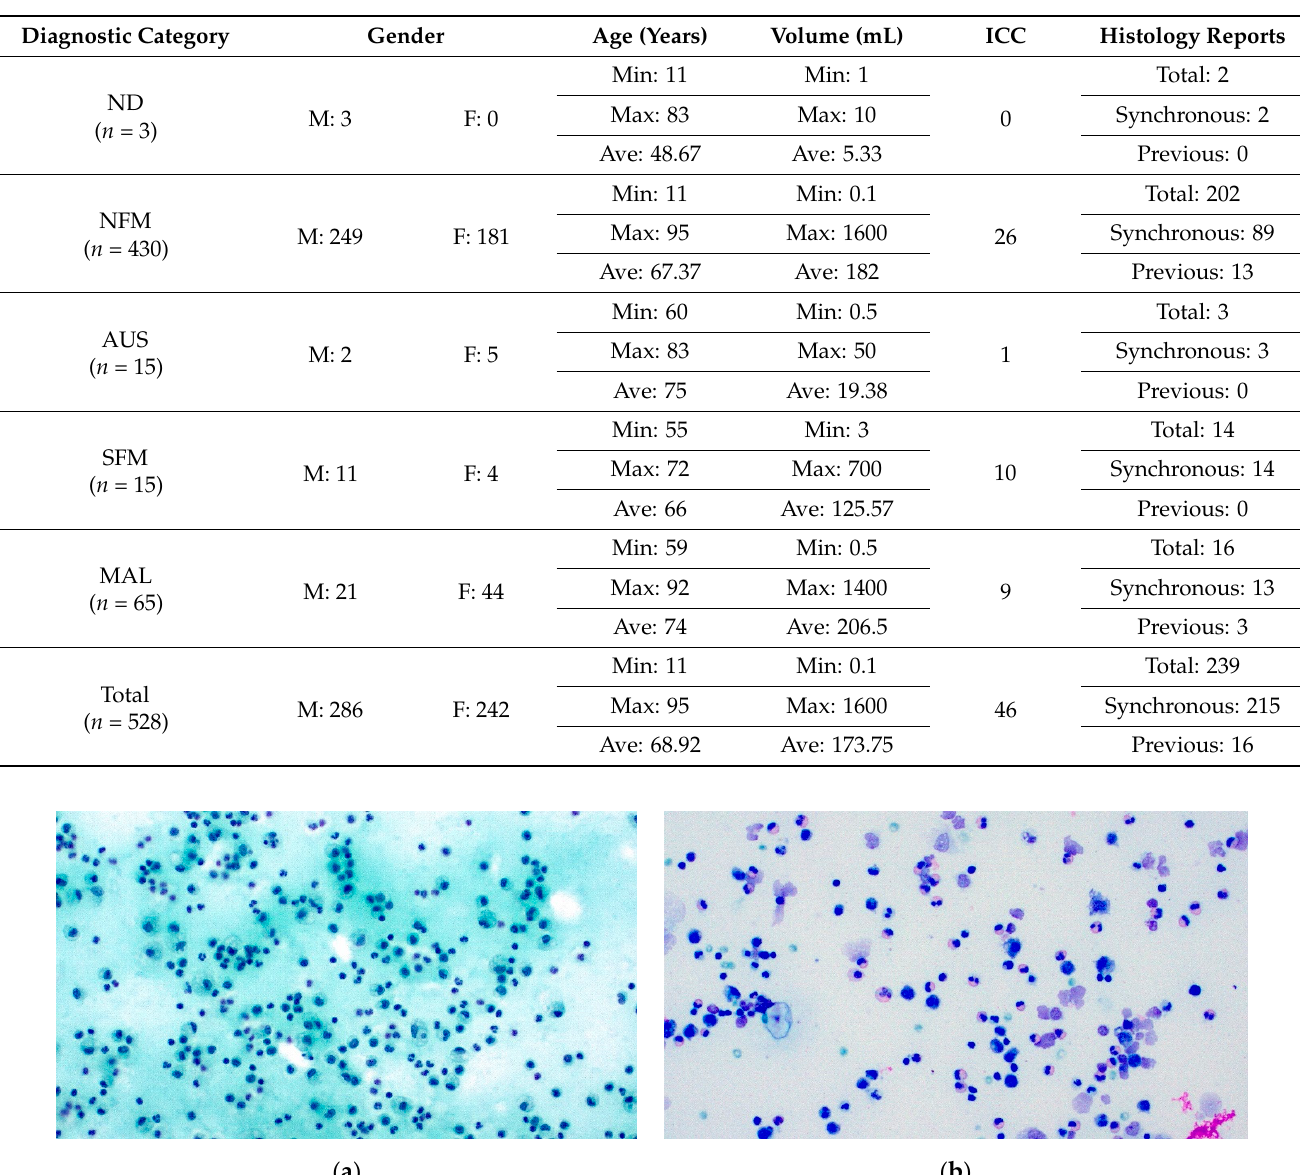
Pleural effusion cases consisted of 286 male and 242 female patients (male to female ratio = 1.18), with age ranging from 11 to 95 years old and median age equal to 68.92 years. Mean specimen volume amounted to 173.75 mL (ranging from 0.1 to 1600 mL). Of 528 cases in total, 3 were classified as ND (0.57%), 430 as NFM (81.44%), 15 as AUS (2.84%), 15 as SFM (2.84%), and 65 (12.31%) were positive for malignancy. ICC was conducted in 46 of the cases. Data are presented in Table 2, and examples of benign and malignant pleural effusions are shown in Figures 1 and 2. Table 2. Number of pleural effusion cases and gender, age, volume, ICC studies and histology report for each TIS category. Diagnostic Category